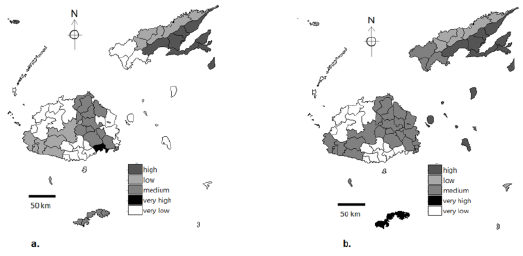
Figure 13. LUI on farms of more than 100ha.